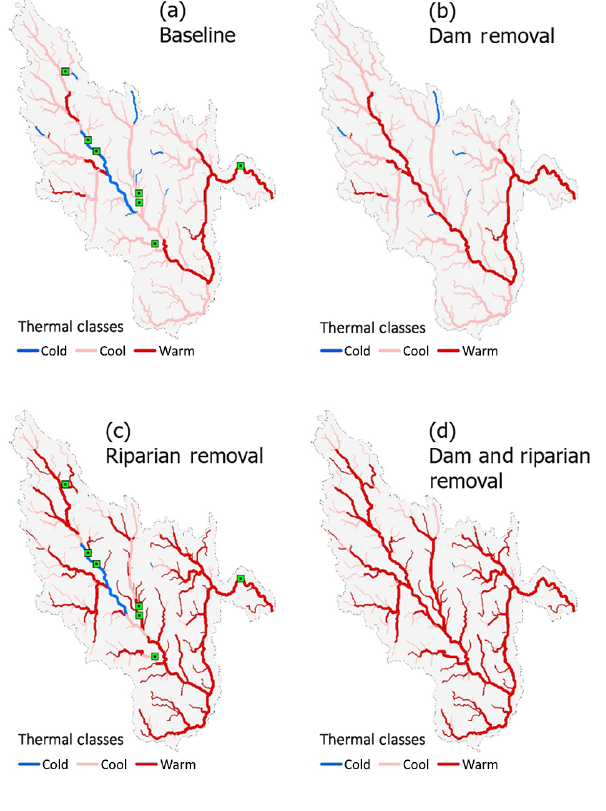
Figure 8. Thermal classes (Cold, Cool, and Warm) in the Farming- ton River basin using simulated results for (a) Scenario 1, (b) Sce- nario 2, (c) Scenario 3, and (d) Scenario 4 from Sect. 3.4. The green square in panels (a) and (c) indicate the location of the